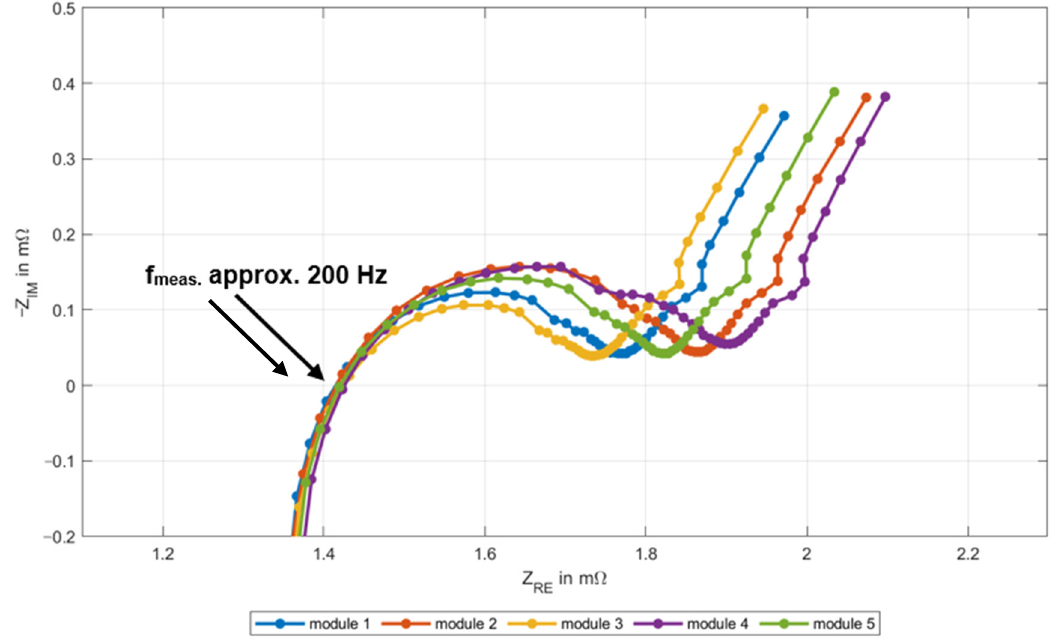
Figure 11. Impedance spectra at 30% SOC of the modules. Modules 1 and 3 were shifted.